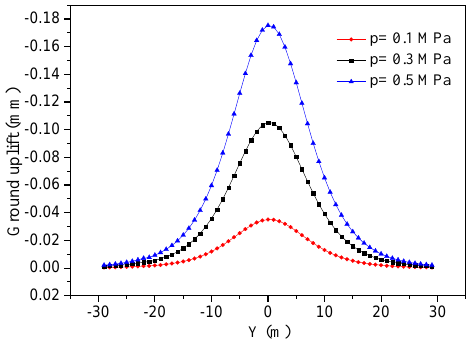
Figure 15. Horizontal displacement of stratum caused by p .